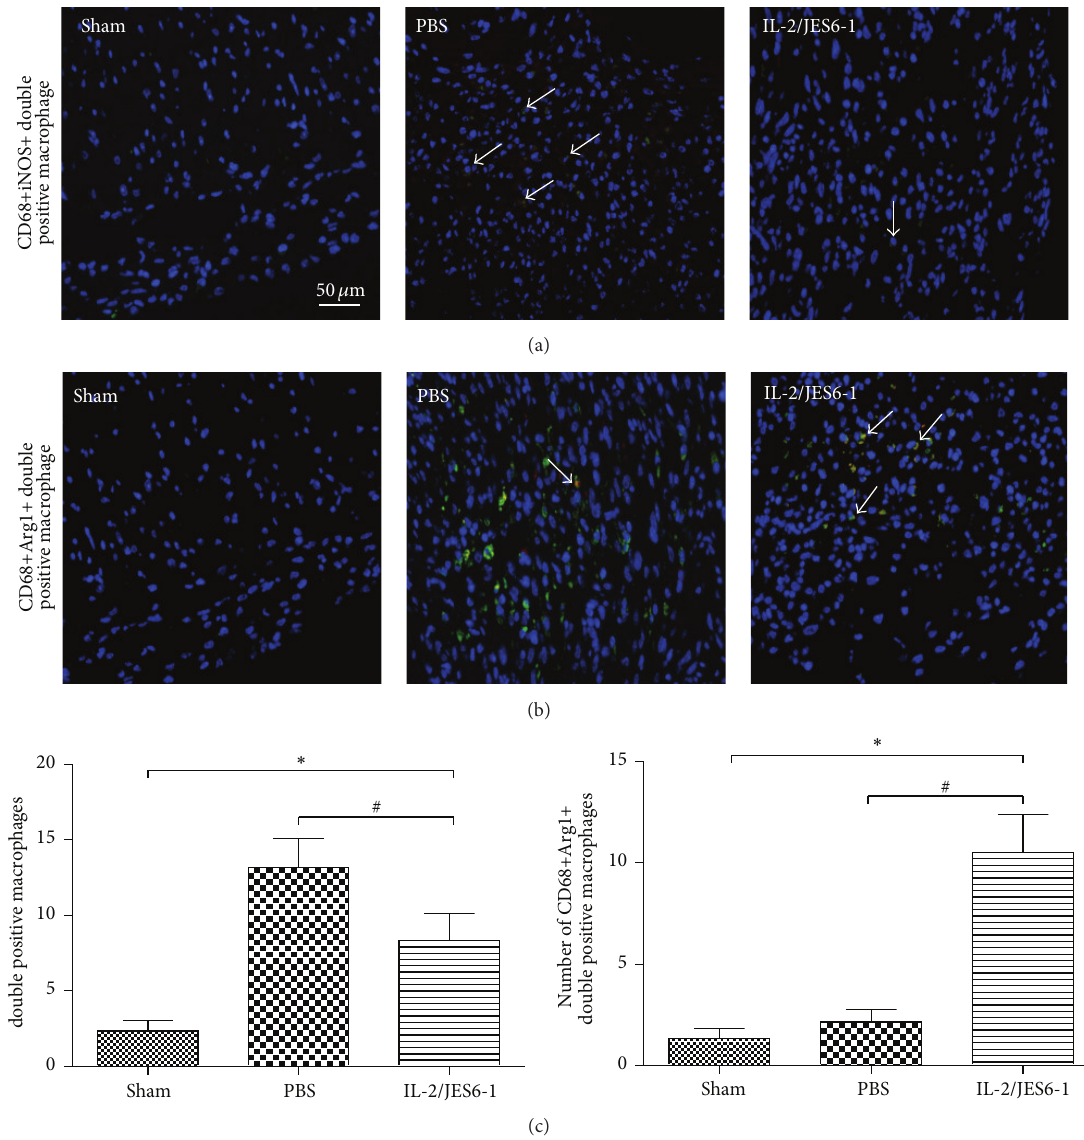
Figure 6: Immunofluorescent double staining of myocardial tissue with antibodies to CD68 and iNOS (a) or to CD68 and Arg-1 (b). Green indicates CD68, red iNOS or Arg-1, and blue DAPI-stained cellular nuclei. CD68+iNOS+ or CD68+Arg-1+ double positive macrophage shows yellow area (arrows). (c) The number of CD68+iNOS+ or CD68+Arg-1+ double positive macrophages in myocardial tissue from the Sham, PBS, and IL-2/JES6-1 treated mice ( 𝑛 = 7 per group). Original magnification × 400; ∗ 𝑃 < 0.05 versus the Sham group, # 𝑃 < 0.05 versus the PBS